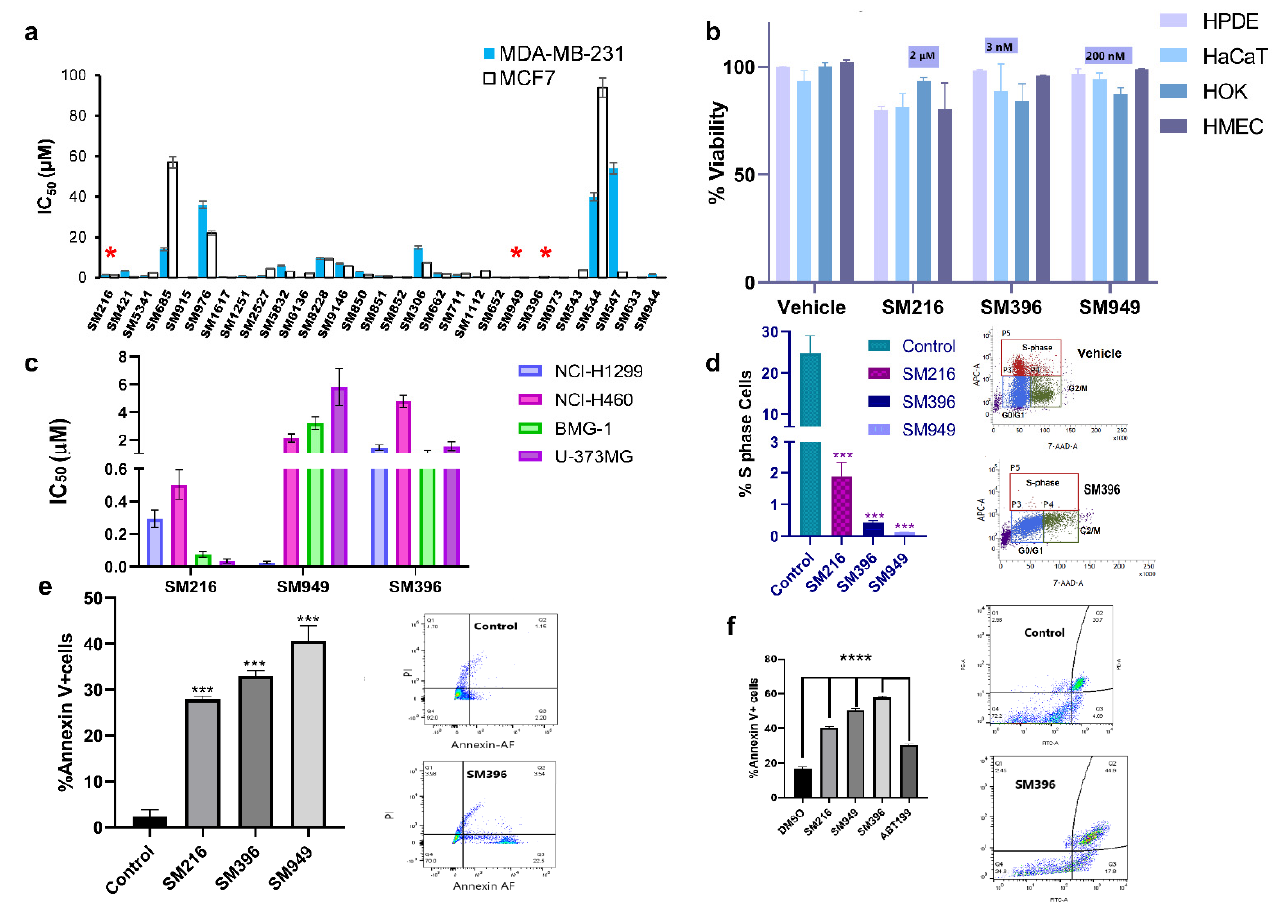
Figure 3. BH4 mimetics SM216, SM396, and SM949 are effective in inducing apoptosis in breast cancer cell lines. ( a ) The IC 50 values estimated from the dose-dependent inhibition curves of 29 lead compounds using the MTT assay (72 h timepoint) for MDA-MB-231 and MCF7 breast cell lines (SM216: 1.866 µ M, SM396: 2.995 nM, and SM949: 0.1875 µ M), ( n = 3, p < 0.001). ( b ) The percentage of cell viability values for normal cells (HPDE, HaCaT, HOK, and HMEC) treated with SM216, SM396, and SM949. The data are represented as mean viability ± SEM ( n = 3, p < 0.05). ( c ) The IC 50 values estimated from the dose-dependent inhibition curves of three lead compounds using an MTT assay (72 h timepoint) for lung cancer cells (NCI-H1299 and NCI-H460) and glioma cells (BMG-1 and U-373MG). ( d ) BrdU cell proliferation assay on MDA-MB-231 cells showing a reduction in % S-phase fraction for SM216, SM396, and SM949, and the vehicle control and representative dot plot for SM216 are shown. ( e ) The percentage of Annexin V + positive cells for SM216, SM396, and SM949 along with representative images from FACS analysis on MDA-MB-231 cells. The data are represented as mean ± SEM for all the assays. ( f ) Bar graph showing the percentage of apoptotic cells upon treatment with the vehicle control, SM216, SM396, SM949. An increase in the apoptotic cell fraction upon SM396 treatment is observed by Alexa Flour 488 Annexin V-PI assay using flow cytometry on BT549 cells at 6 h time-points shown in the representative pictures. *, *** and **** indicate p ≤ 0.05, p ≤ 0.001 and p ≤ 0.0001, respectively.